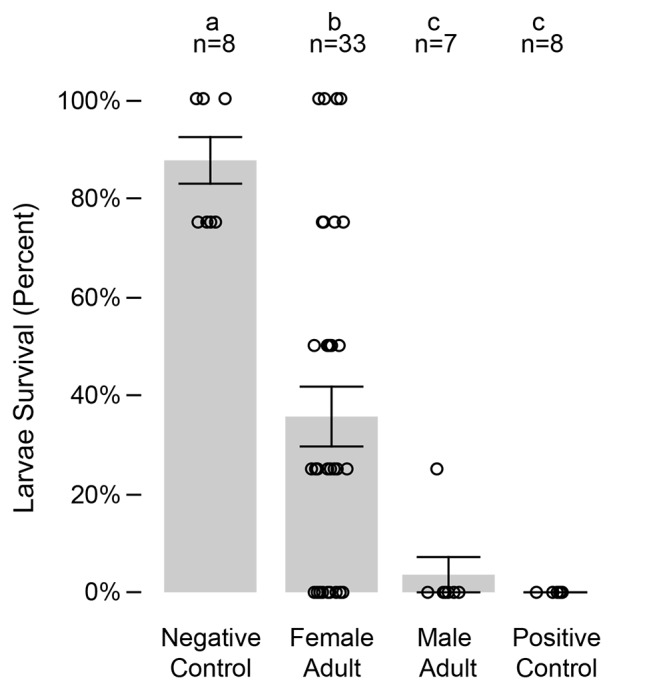
Adults removed from field cages were examined for insecticidal activity using immature bioassays.Letters above the bars indicate significant differences (p < 0.01, Wilcoxon). The number of replicates is shown above each column. Bars show standard errors.